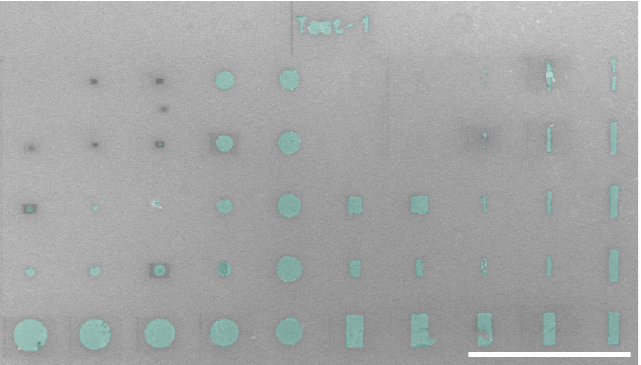
Figure 10. Nanoparticles self-assembly using PMMA. False color SEM image of patterned circles and rectangles of magnetic nanoparticles. The scale bar is 50 µ